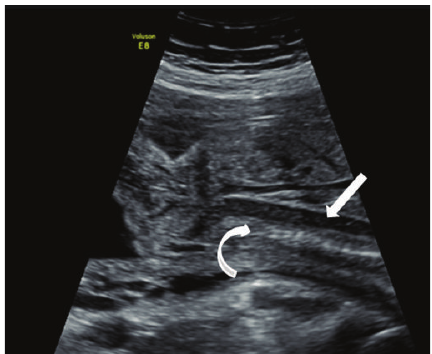
Figure 1: Sagittal view of the fetus showing hypomineralization of the vertebrae (curved arrow) and an echolucent and tubular structure anterior to the spine (straight arrow), ending at the end of the sacrum.